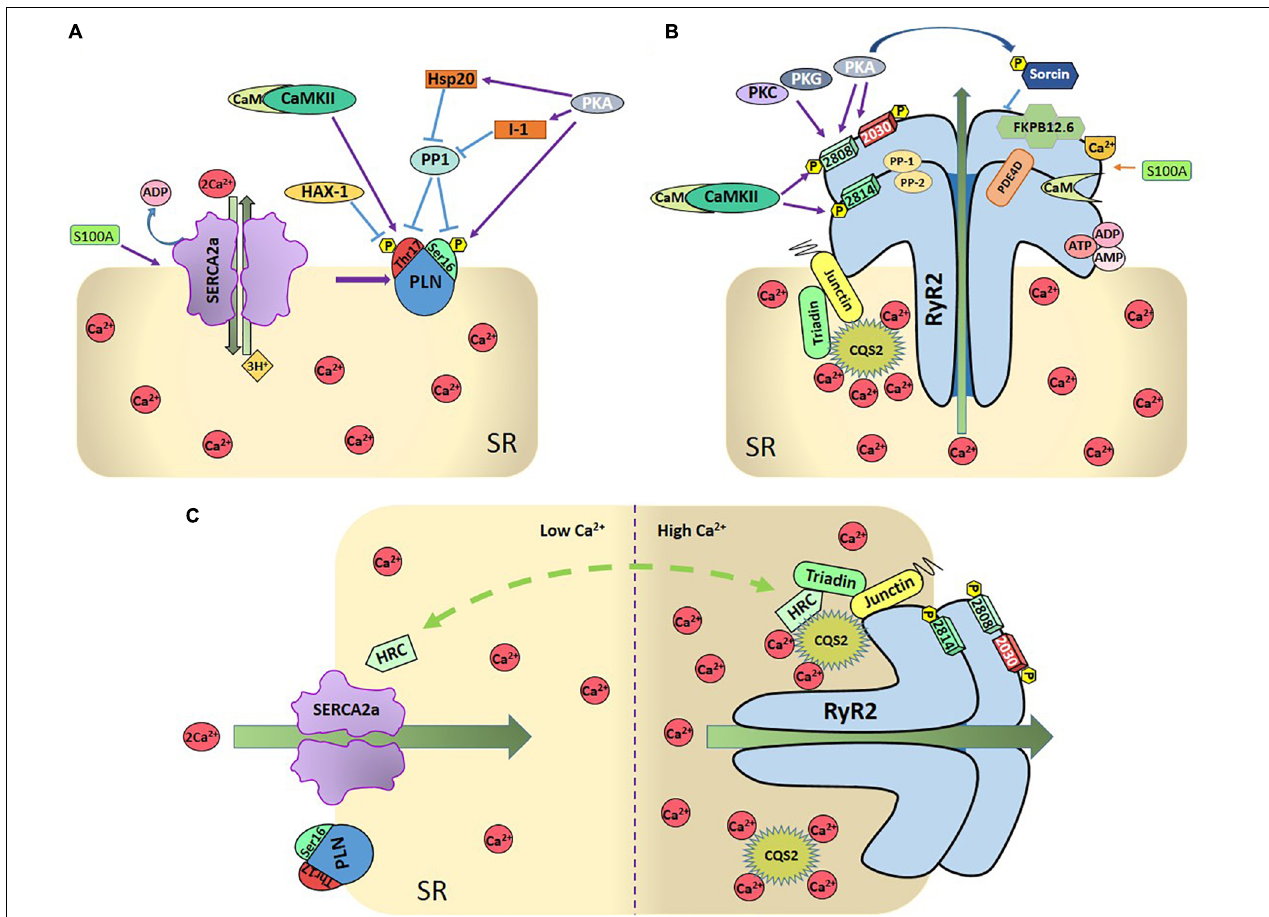
FIGURE 2 | (A) Regulation of SR-Ca 2 + uptake. SR- Ca 2 + uptake takes place through the SR- Ca 2 + ATPase (SERCA2a), being PLN the main regulatory protein of SERCA2a. PLN can be phosphorylated by PKA at Ser 16 residue and by Ca 2 + -calmodulin-dependent protein kinase (CaMKII) at Thr 17 site. Protein phosphatase 1 (PP1) dephosphorylates both sites. Either one or both phosphorylation sites relieve PLN inhibition on SERCA2a. Several other proteins regulate SERCA2 either directly, like S100A or Sumo1, or indirectly, through the regulation of PLN (like the hematopoietic lineage cell-specific protein-1 (HS-1) associated protein X-1 (Hax-1), the Heat-shot protein 20 (Hsp20), and the inhibitor 1 (I-1). As described in the text, PLN and SERCA2a are also regulated by redox processes and SERCA by acetylation and glycation (Not shown in the Figure for the sake of clarity). (B) Regulation of SR-Ca 2 + release: SR-Ca 2 + release occurs mainly through the